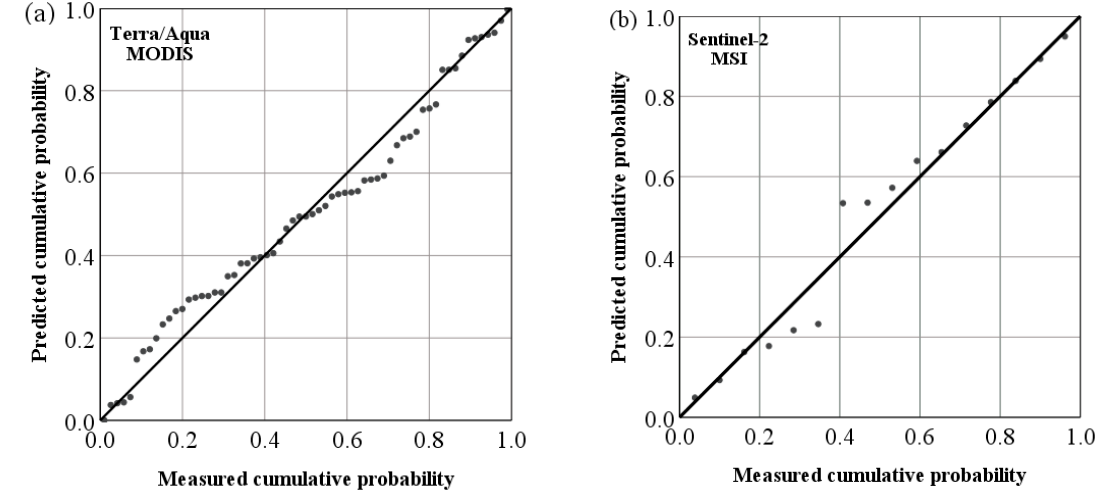
Figure 8. Residual normal distribution of HAB areas extracted by MODIS and Sentinel-2: ( a ) the coefficient of determination (R 2 ) was 0.98 between MODIS and visual interpretation, and ( b ) R 2 was 0.99 between Sentinel-2 and visual interpretation.